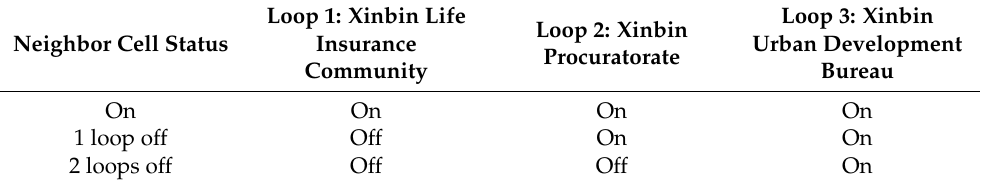
Table 2. Test Base Station On/Off.